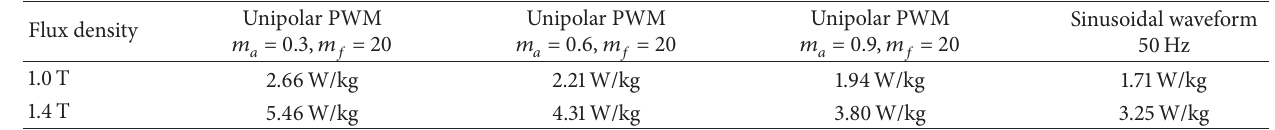
Table 3: Iron losses for a sinusoidal waveform and unipolar PWM (with 𝑓 = 50 Hz) obtained using the new toroidal frame. Flux density